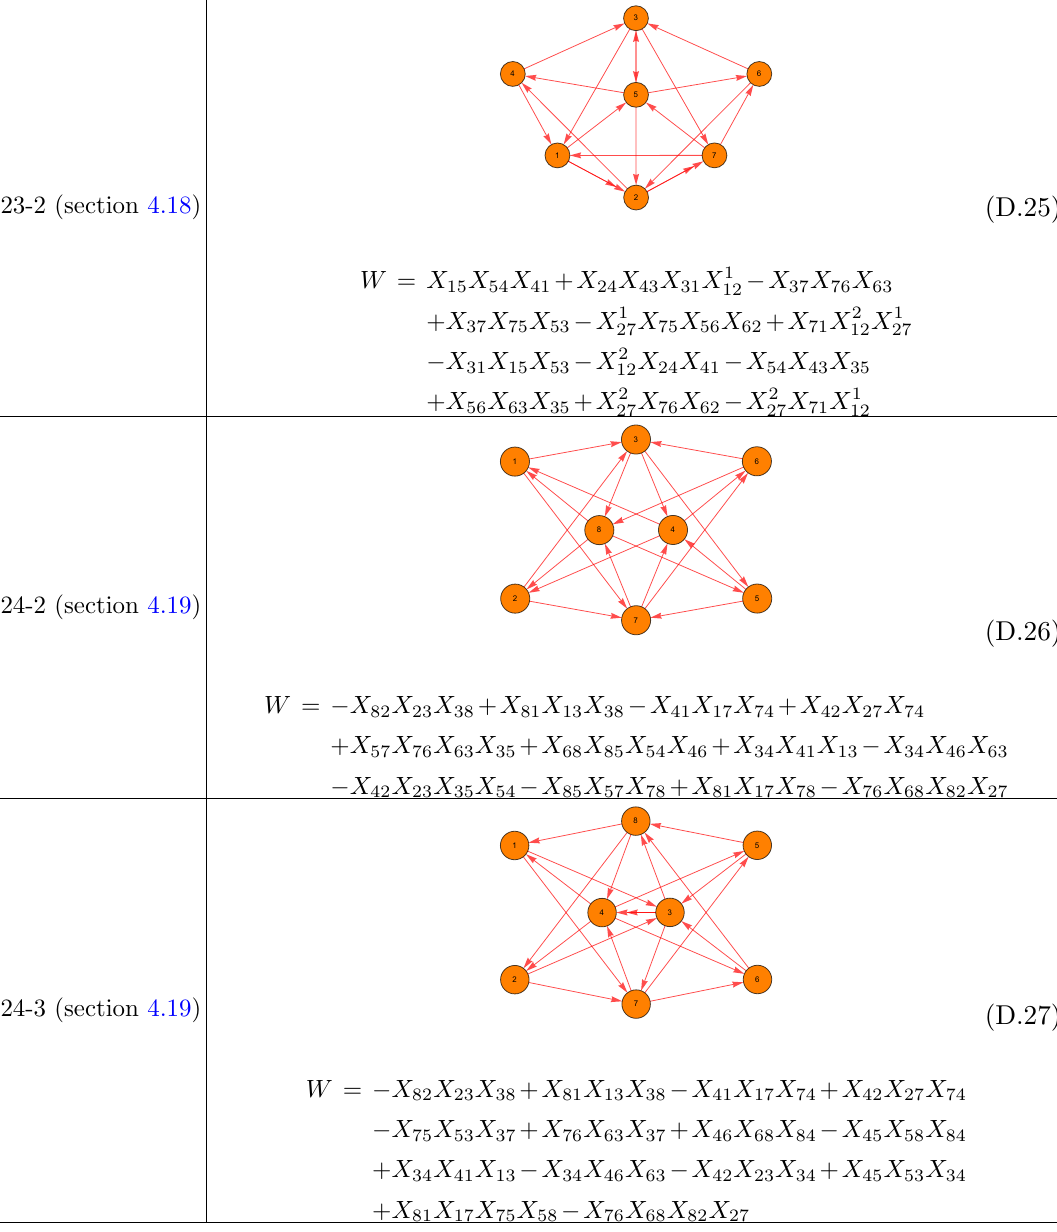
Table 4. The remaining toric phases of